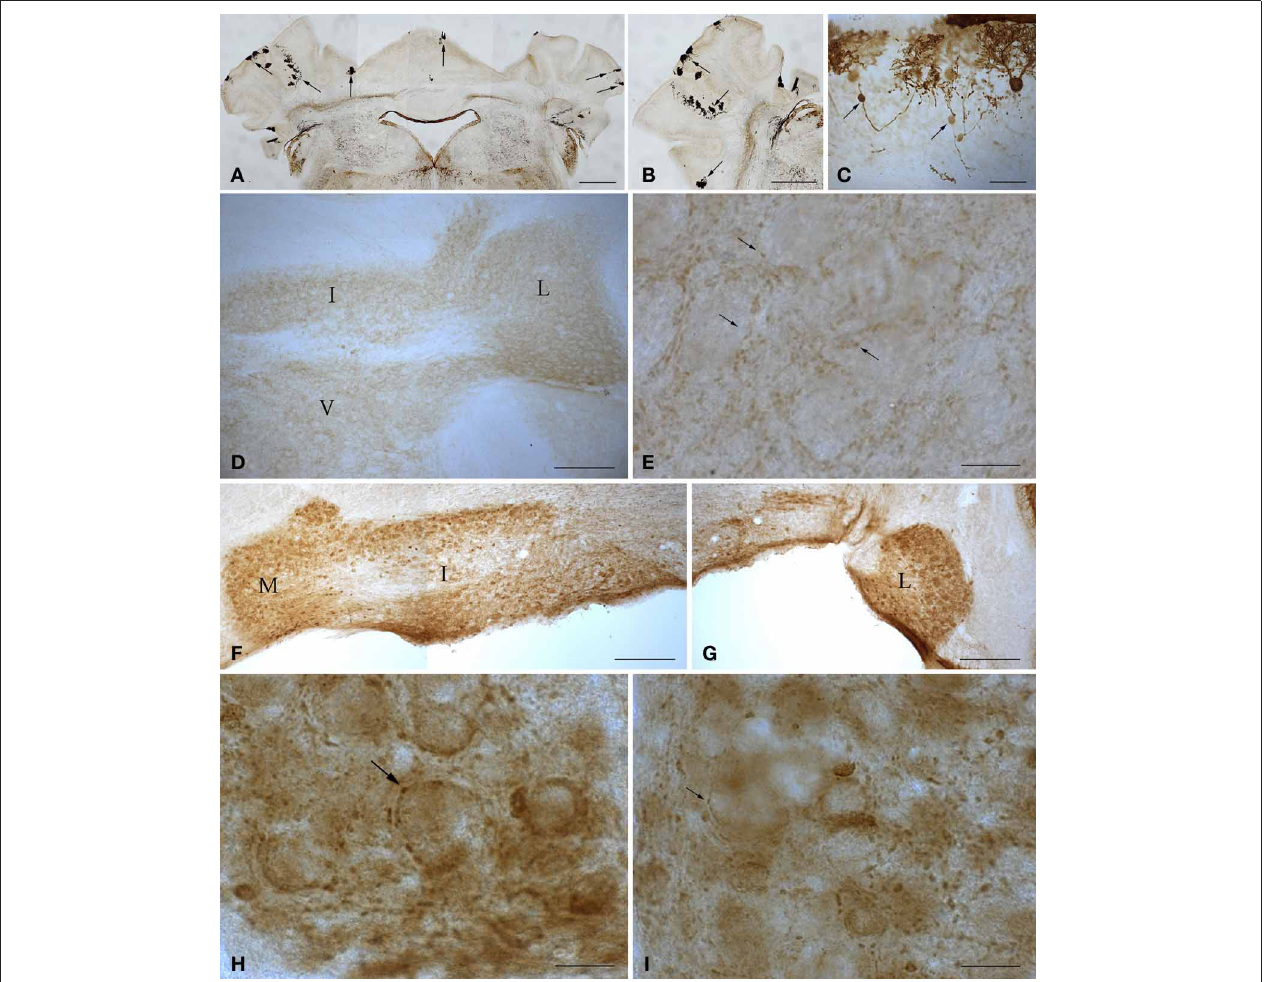
FIGURE 2 | Microphotographs of coronal (A, D–I) and sagittal (B,C) sections immunostained with anti-calbindin (A–C) and anti-parvalbumin (D–I) antibodies illustrate the main features of the cerebellum of wild type and 1-year-old tambaleante mice. Scarce Purkinje cells remain throughout the cortex ( A–B , arrows), preserving a mirror location on both sides of the cerebellar cortex ( A , arrows). Axons of degenerating Purkinje cells show typical axonal torpedoes ( C , arrows). Parvalbumin